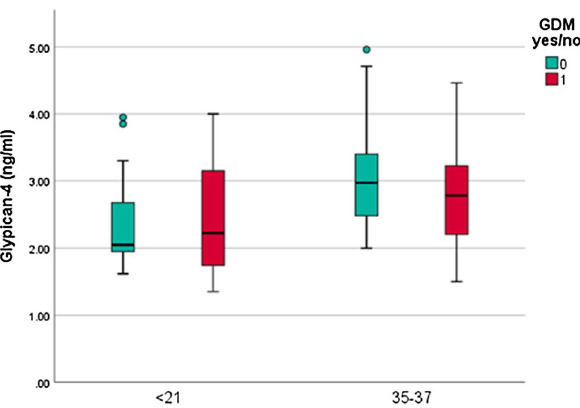
Figure 1. Clustered boxplot of GPC-4 levels by GDM status throughout pregnancy. GPC-4 was significantly higher at gestational week (GW) 35–37 than before GW 21. There was no significant difference in GPC-4 levels between women with NGT and